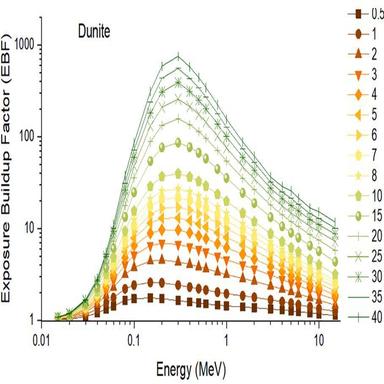
Variation of exposure buildup factor (EBF) values of dunite as a function of photon energy (MeV).